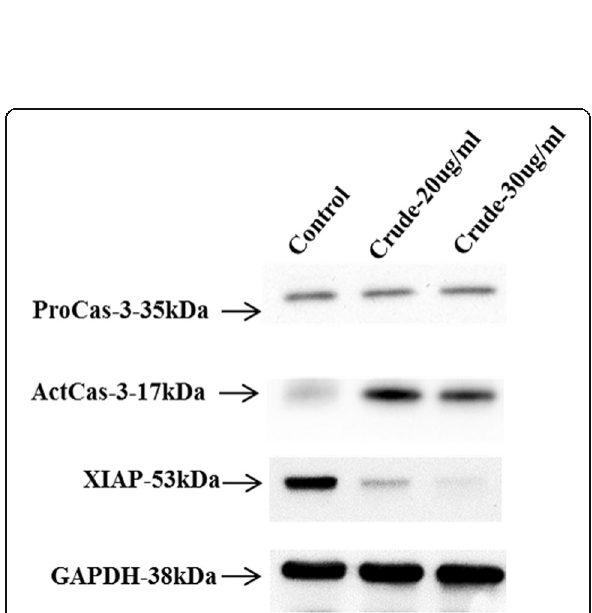
Fig. 4 Apoptosis in oral cancer cells induced by the Danshen crude. Lysates of the SAS cells treated with extract (20 and 30 μ g/mL) for 24 and 48 h were subjected to an immunoblot analysis with antibodies against caspase-3 and XIAP. GAPDH served as the loading